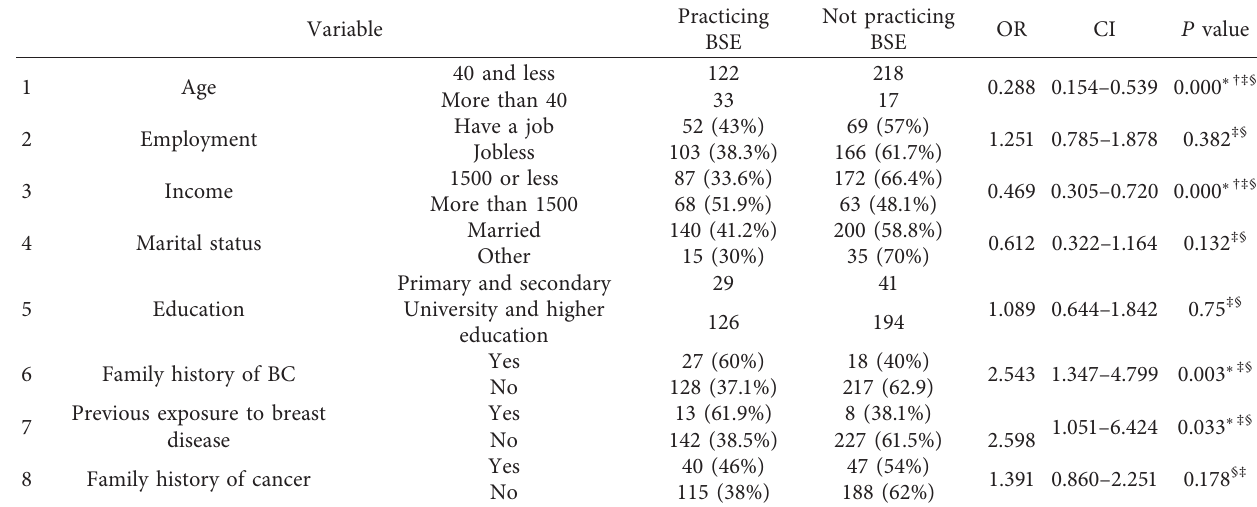
Table 5: Bivariate analysis: association between breast self-examination (BSE) and sociodemographic variables.